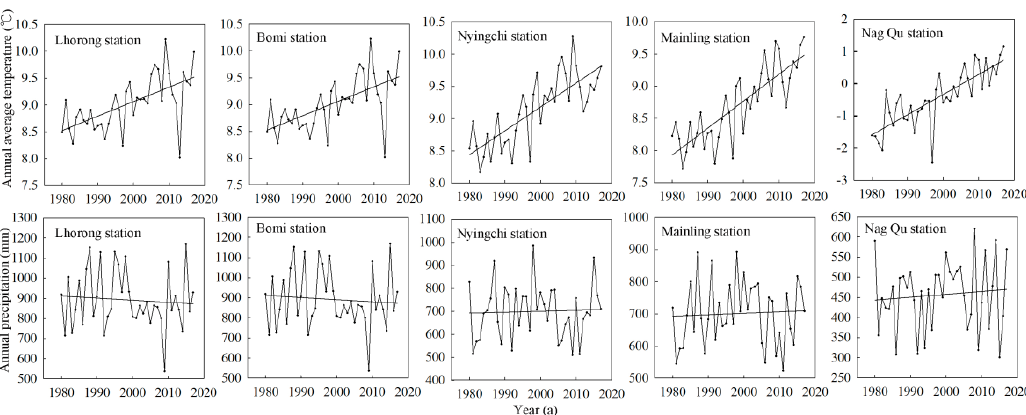
Figure 9. Changes of annual average temperature and annual precipitation at five meteorological stations around the Yi’ong Zangbo River Basin from 1980 to 2017. Water 2020 , 12 , 538